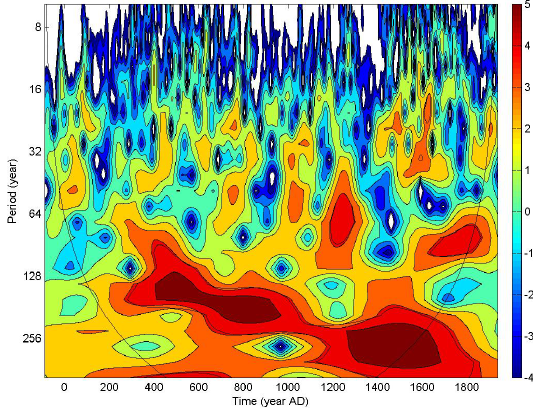
Fig. 5. Wavelet (Morlet) spectrum (Torrence and Compo, 1998) of the interpolated SPA record for the period − 90 until 1935AD. The solid black line from the left to the right top of the figure is the cone of influence (below the cone of influence, the results are not significant). The spectrum shows that the power density transfers with time from the ∼ 125-yr cycle to the ∼ 250-yr cycle (period